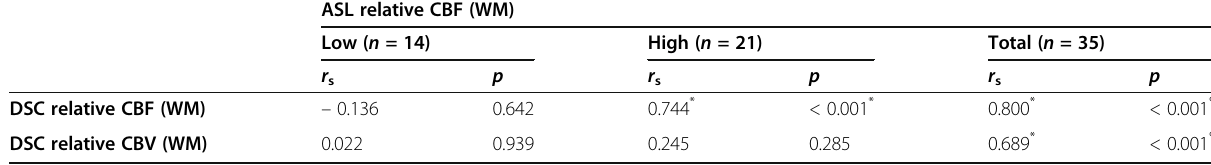
Table 6 Correlation between ASL rCBF, DSC-PI rCBF, and rCBV in each group (low- and high-grade gliomas) and total